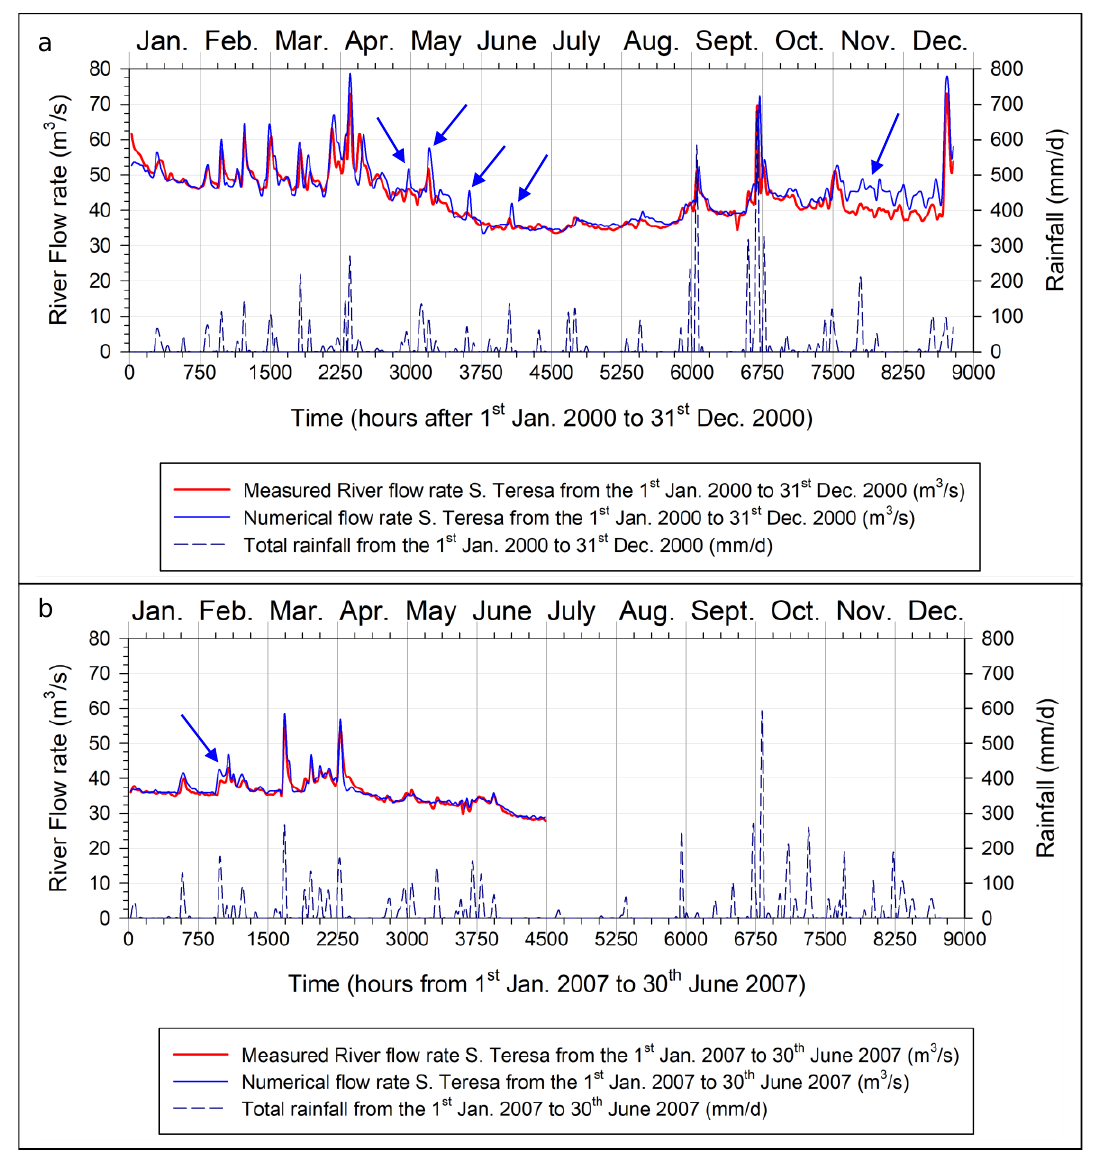
Figure 7. Comparison of measured river flow data at S. Teresa station and the numerical river flow rate data resulting from the validation test related to the years: ( a ) 2000 and ( b ) 2007. Dashed dark blue line: total rainfall (mm); solid red line: measured river flow rate (m 3 /s); solid blue line: numerical river flow rate (m 3 /s).